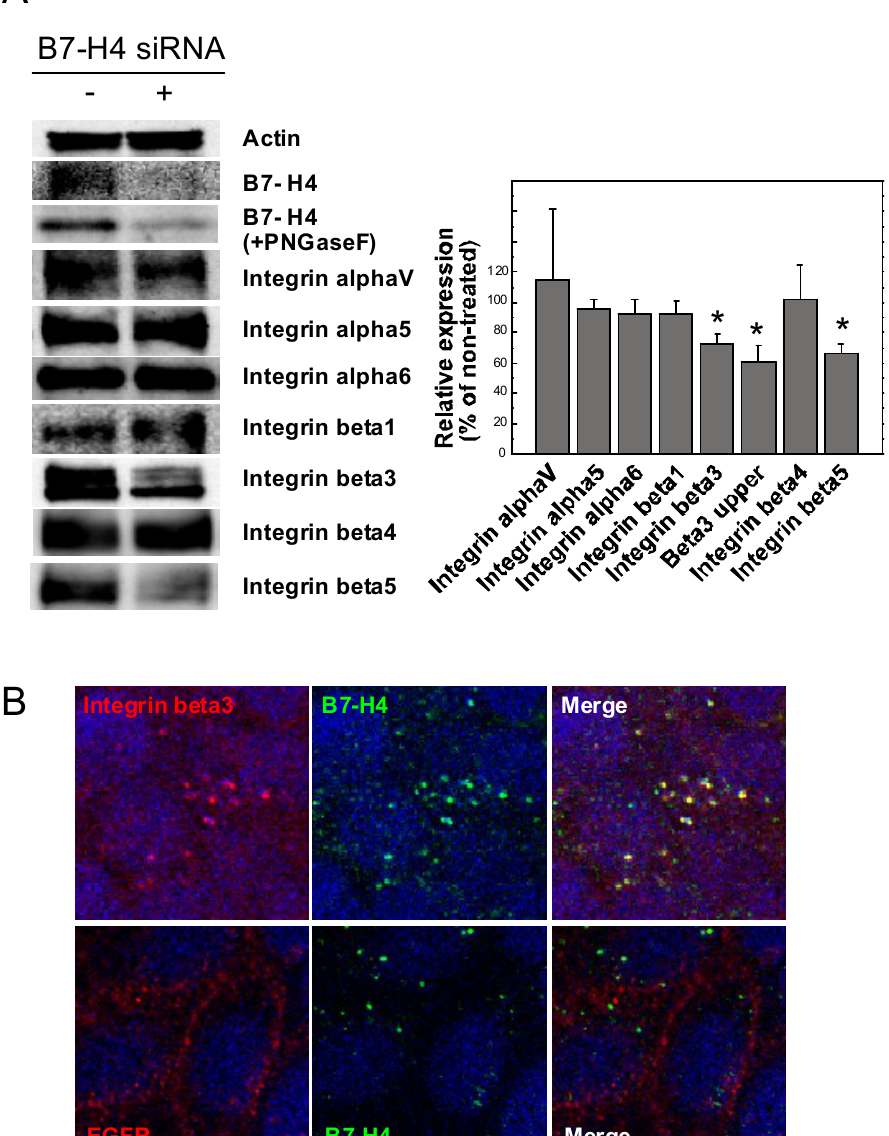
Figure 4. Survey of association between B7-H4 and integrins. ( A ) Effect of B7-H4 siRNA on levels of various integrins in MKN28 cells. After 48 h of B7-H4 siRNA treatment, integrin levels were assessed by western blot analysis. The value of relative protein levels is indicated in the right panel. The data in the bar graph represent combined data from two experiments, one of which is shown in the immunoblot representations. Asterisks indicate values significantly different ( p < 0.01) compared with the non-treated control. ( B ) Co-localization of B7-H4 and integrin β3. Cellular distribution of B7-H4 (green) and integrin β3 (red) was observed by immunofluorescence microscopy (upper panels). Differential cellular distribution of B7-H4 (green) and EGFR (red) was also observed (lower panels). Co-localization of both proteins is represented as a yellow signal (merged panel). Nuclei within the cells were stained with DAPI.